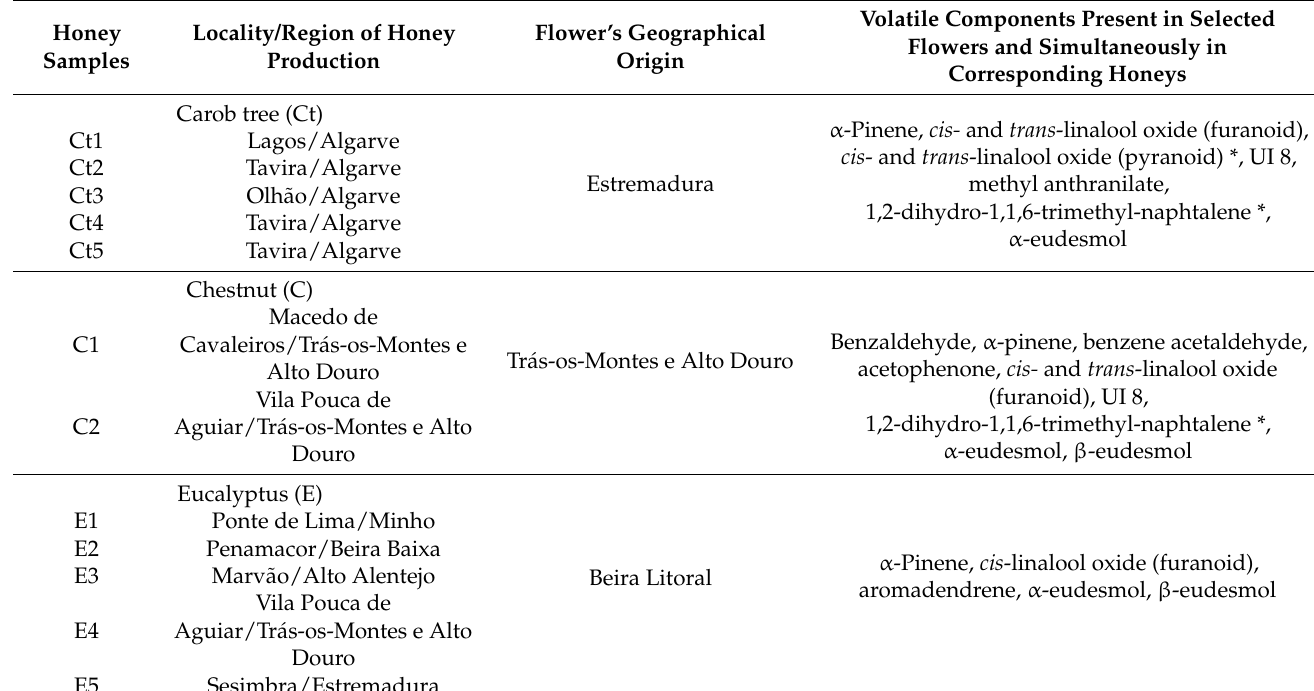
Table 1. Monofloral-labelled honeys studied, their production regions and analysed flower types, with corresponding geographical origins and volatile components found in each honey’s botanical